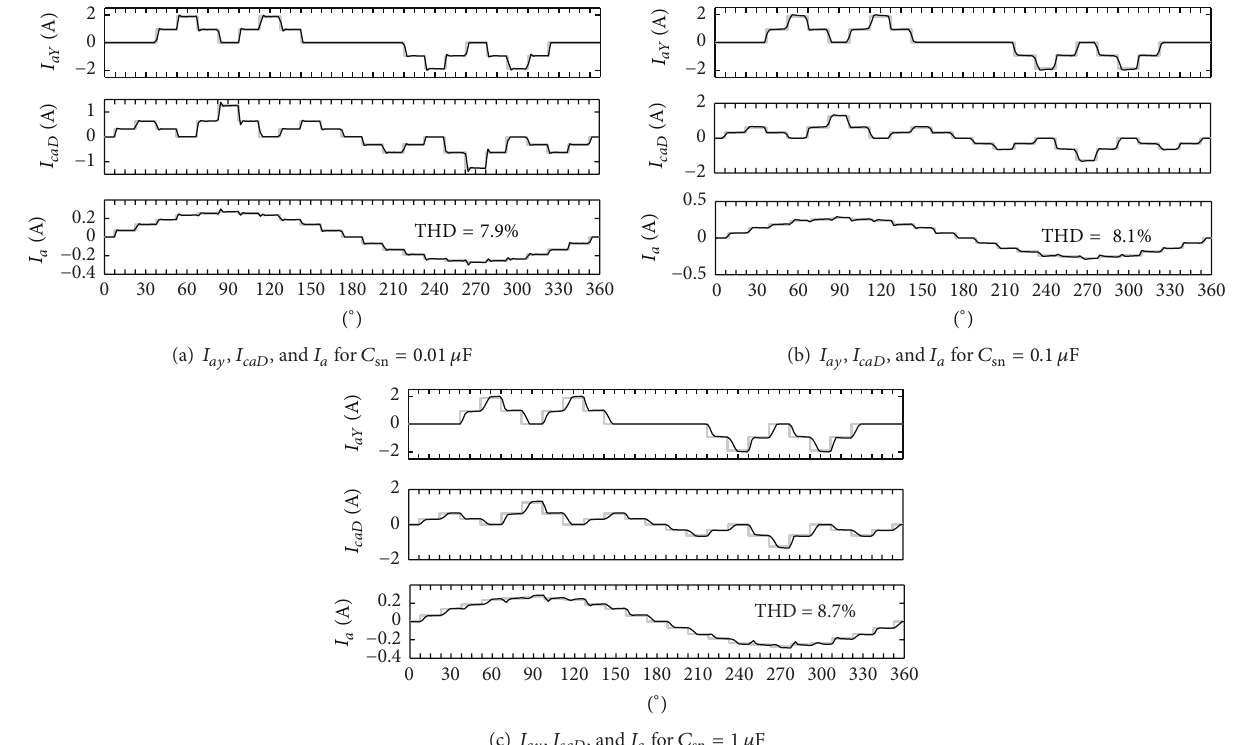
Figure 12: Simulated AC side current and DC bus waveforms for the 3-level thyristor based MLCR CSC.